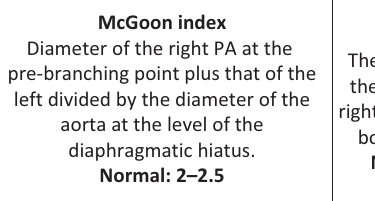
FIGURE 7: McGoon and Nakata